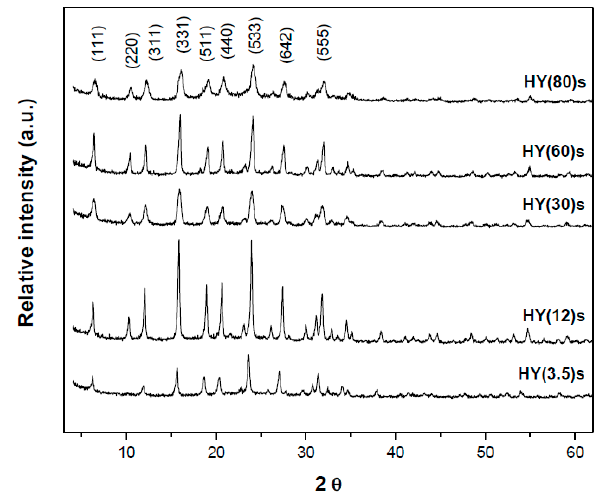
Figure 10. X-ray diffraction patterns of the spent zeolites. The average crystallite sizes of the spent catalysts were estimated from the integrated area of the reflection corresponding to the (111) plane and are reported in Table 4. In comparison with the respective fresh zeolites, the crystallites of the spent samples increased by 1.38%, 2.14%, 1.53%, 0.97% and 0.92% in the order HY(3.5)s, HY(12)s, HY(30)s, HY(60)s and HY(80)s. This increase in the crystal sizes was attributed to the deposition of coke inside the micropores, causing an expansion of the unit cell of the